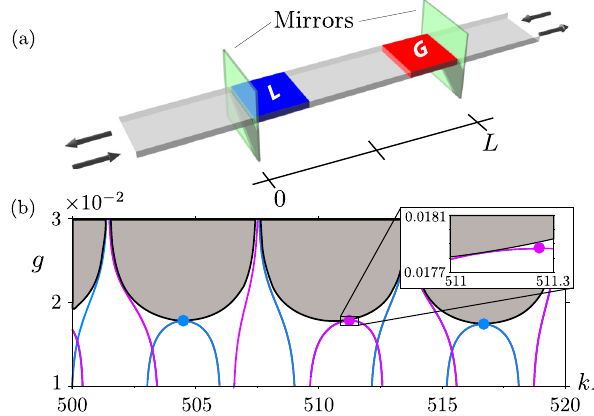
FIG. 1. (a) One-dimensional scattering system featuring a layer of loss (blue region) and gain (red region), separated by an air gap (the real part of the refractive index n 0 ¼ 1 through- out). A variable coupling strength between the cavity and the asymptotic region can be introduced by two semitransparent mirrors (green regions). (b) Regions of unbroken (white) and broken (gray) PT symmetry for the scattering matrix of the system displayed in (a). ( P denotes spatial reflection at x ¼ L= 2 .) The ‘‘exceptional line’’ (black) at the boundary between these two regions contains all the PT -breaking points in the scattering-matrix eigenvalues occurring at specific values of kL and strength of loss and gain g . Embedding into this plot also the (real) eigenvalues below threshold of the Helmholtz equation in the bounded domain with Dirichlet (blue lines) or Neumann (purple lines) BCs imposed at x ¼ 0 ; L , we find that the symmetry-breaking points of these eigenvalues (see the colored dots) lie in close vicinity but not exactly on the excep- tional line of the S -matrix eigenvalues (see the